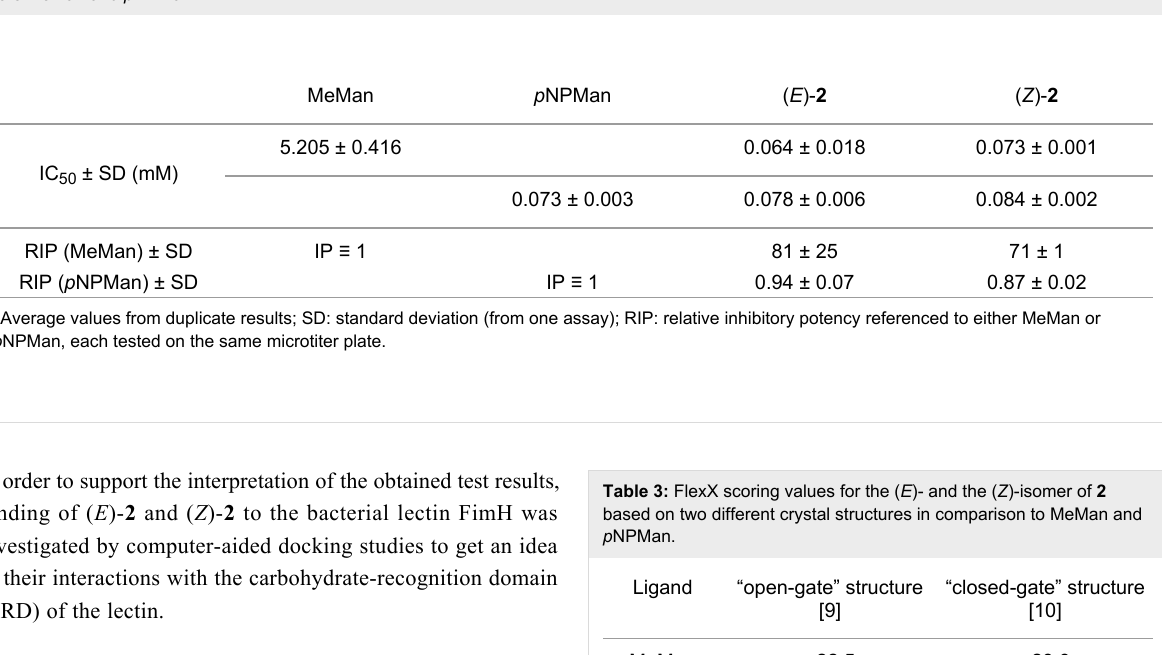
Table 2: Inhibition of adhesion of E. coli to a mannan-coated surface. The inhibitory potencies of ( E )- and ( Z )- 2 are compared to the standard inhibi- tors MeMan and p NPMan. a